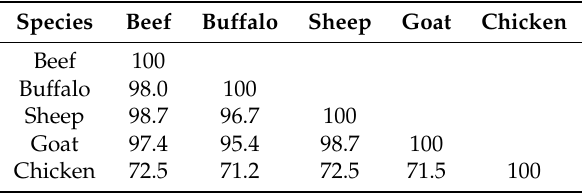
Table 1. Similarity percentage among red meat and Poultry Mb